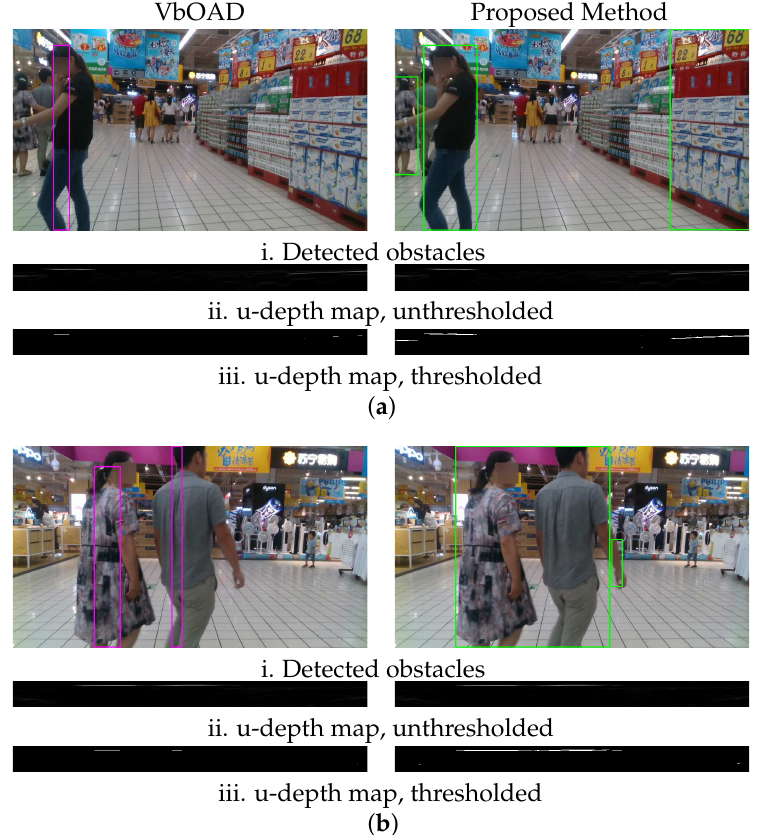
Figure 23. The effectiveness of the proposed dynamic thresholding against fixed thresholding as pro- posed in VbOAD [28] on the market sequence of the Open LORIS-Scene data set [29]. ( a ) Example 1. ( b ) Example 2.